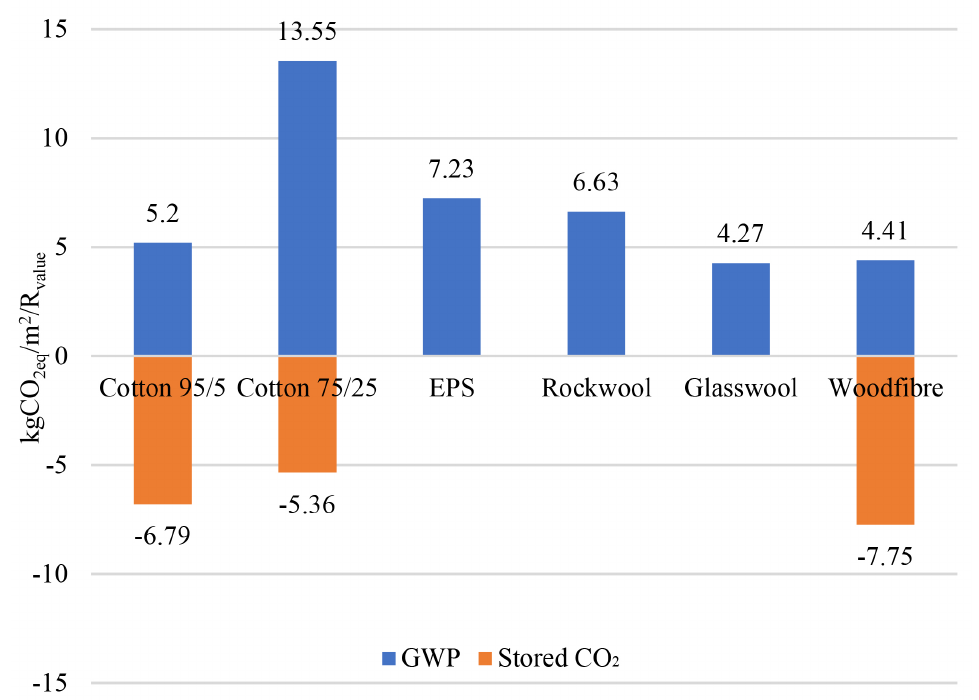
Figure 5. Carbon footprint (GWP) and CO a R T = 2.2 m 2